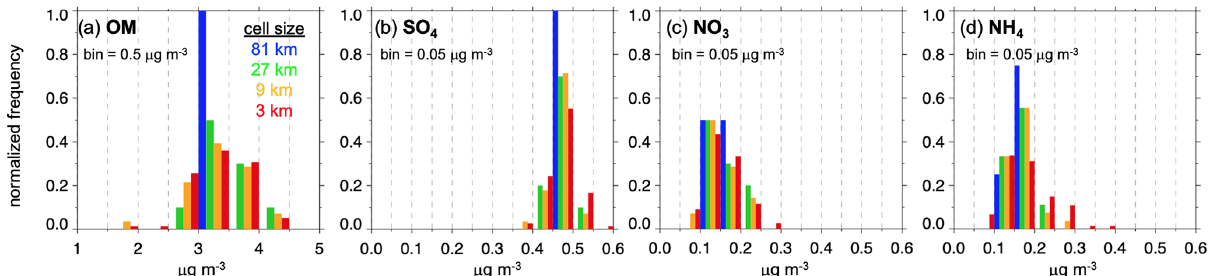
Figure 4. Normalized frequency of occurrence for (a) OM, (b) SO 4 , (c) NO 3 , and (d) NH 4 concentrations observed for the 7 May flight shown in Fig.